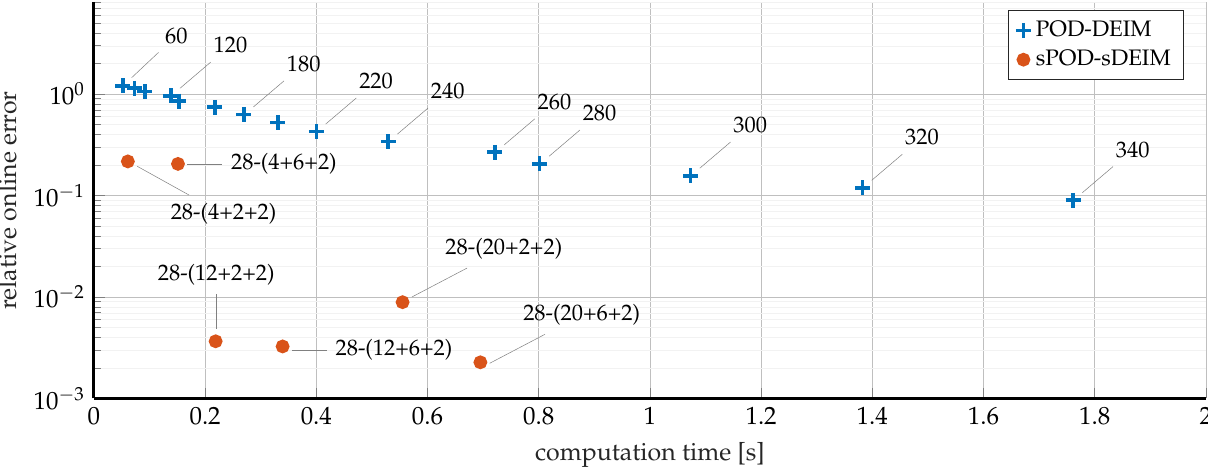
Figure 10. Comparison of computation time and accuracy for β = 558.49 K with the initial condition (26) for different mode numbers: sPOD-sDEIM ROM (blue stars) vs. POD-DEIM ROM (red circles). For the POD-DEIM ROMs, the number indicates the total number of POD modes used for this ROM. For the sPOD-sDEIM ROMs, the first number denotes the POD modes before the switch. The numbers within the parentheses are the number of transformed modes, the number of POD modes after the switch, and the path